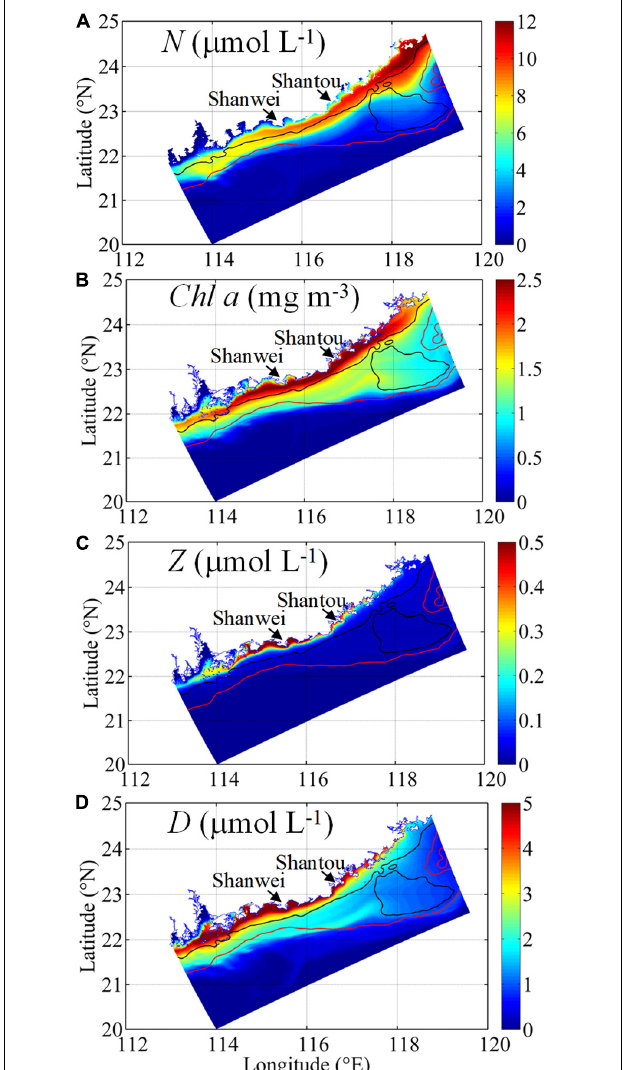
FIGURE 7 | Surface (A) nitrate, NO 3 ( N , µ mol L − 1 ), (B) chlorophyll (Chl a , mg m − 3 ), (C) zooplankton ( Z , µ mol L − 1 ), and (D) detritus ( D , µ mol L − 1 ) on Day